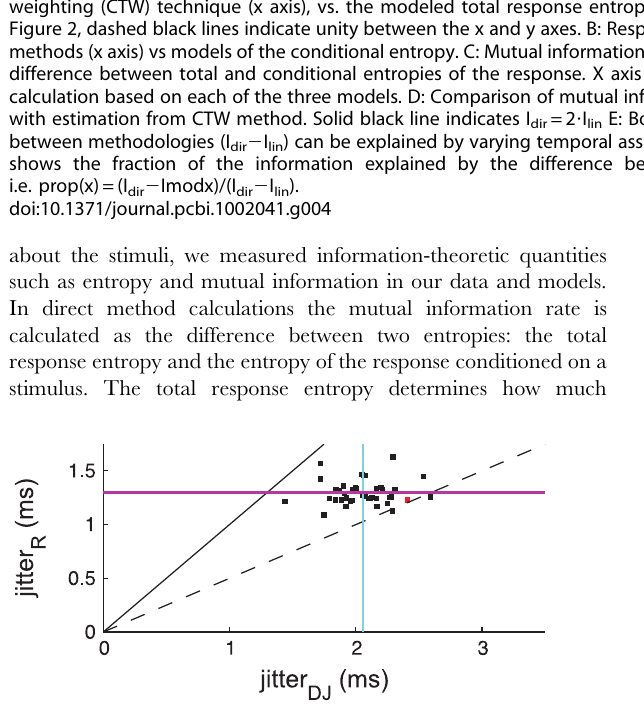
Figure 5. Temporal precision of isolated single spikes. Value along the abscissa shows single spike precision assessed by the dejittering algorithm for 40 cells (population mean shown as a vertical cyan line). Value along the ordinate shows single spike precision assessed by a raster-based analysis for the same cells (population mean shown as horizontal purple line). Each cell is represented by a single point (red point is from same recording shown in Figure 1A–C). The solid black line denotes where the two methods give equal results, while the dashed black line shows where the dejittering method gives a value twice as large as the raster analysis.